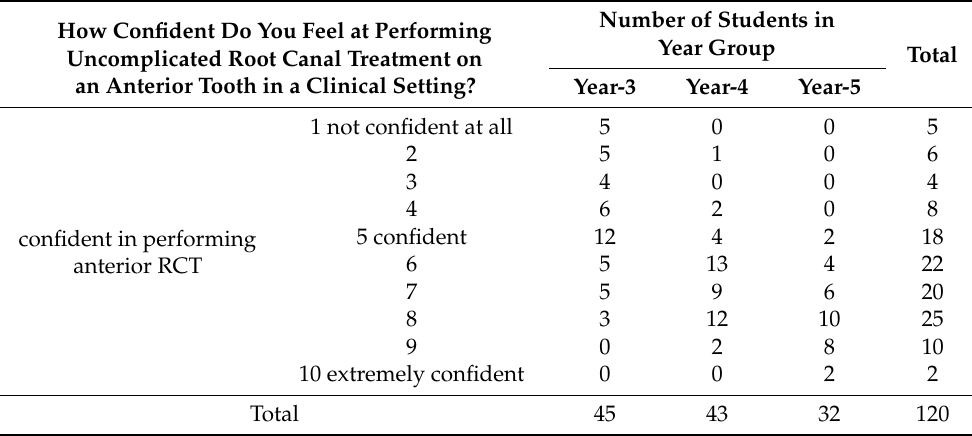
Table 1. The confidence of students in performing anterior root canal treatment (RCT).